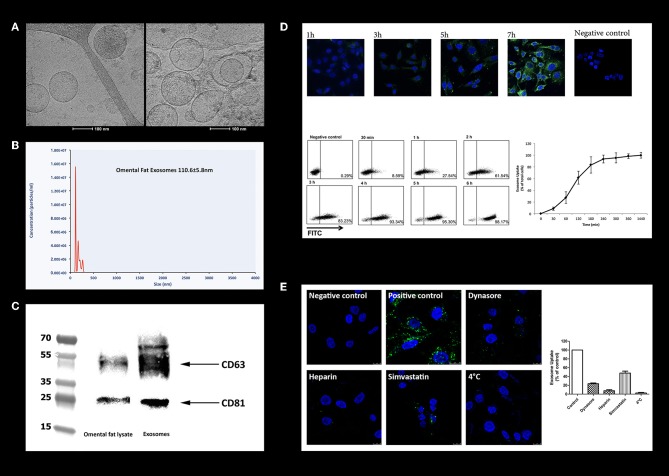
Characterization of human omental tissue-derived exosomes. (A) Exosomes were isolated from the CM of human omental tissue explants and analyzed by cryogenic transmission electron microscopy (Cryo-TEM); Scale bar = 100 nm. (B) Measurement of omental tissue exosomes diameter by nanoparticle tracking analysis system; (C) Western blot analysis of the exosome markers CD81 and CD63. Representatives of three independent experiments are shown; (D) PKH-67-labeled omental tissue exosomes were incubated with AGS gastric cancer cells, reaction was stopped at different time points (1, 3, 5, and 7 h) and cells were analyzed by confocal microscopy (upper panel). The cell's nucleus was stained with Dapi. PKH-67 labeled omental tissue exosomes were incubated for the indicated time points (30 min, 1, 2, 3, 4, 5, and 6 h) with AGS gastric cancer cells. Internalization was measured by flow cytometry (lower panel). Negative control-AGS cells with no addition of labeled exosomes. The data are presented as mean ±SD of four independent experiments; (E) AGS cells were pre-treated with 80 μM Dynasore or 10 ng/mL Heparin for 30 min or with 2 μM Simvastatin for 16 h. PKH-67 labeled omental tissue exosomes were incubated with untreated (positive control) or treated cells for 3 h and uptake was measured by flow cytometry analysis (right panel). The data are presented as the mean percent of cells that uptake labeled exosomes ± SD of three independent experiments; PKH-67 labeled omental tissue exosomes were incubated with untreated (positive control) or treated cells (Dynasore, Heparin or Simvastatin) and internalization was measured by confocal microscopy (left panel). Scale bar is 10 μm.